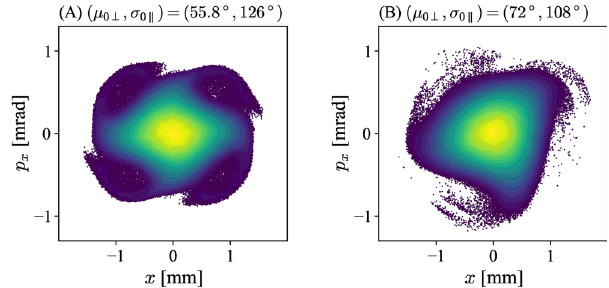
FIG. 6. Horizontal phase-space distributions after the waterbag beam goes through 60 AG cells at the operating points (A) and (B) in Fig. 5(b). As an example, we have assumed a 10 MeV proton bunch whose horizontal emittance is 0 . 1355 π mm · mrad at